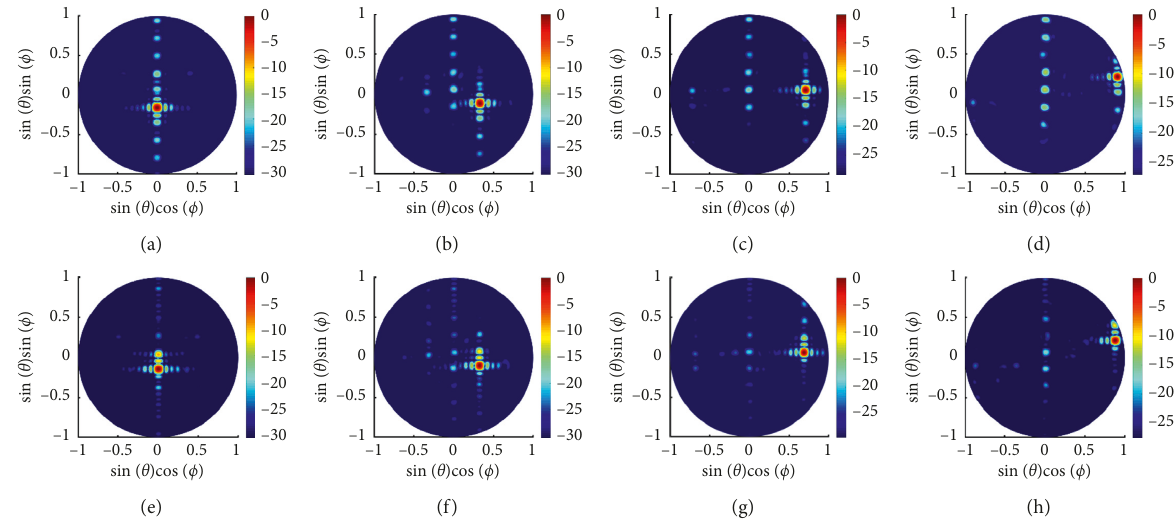
Figure 8: Simulated patterns, where the colour represents the dB level: (a–d) 11.75GHz and (e–h) 12.25GHz. Rotation angles of (a) 0 ° , (b)